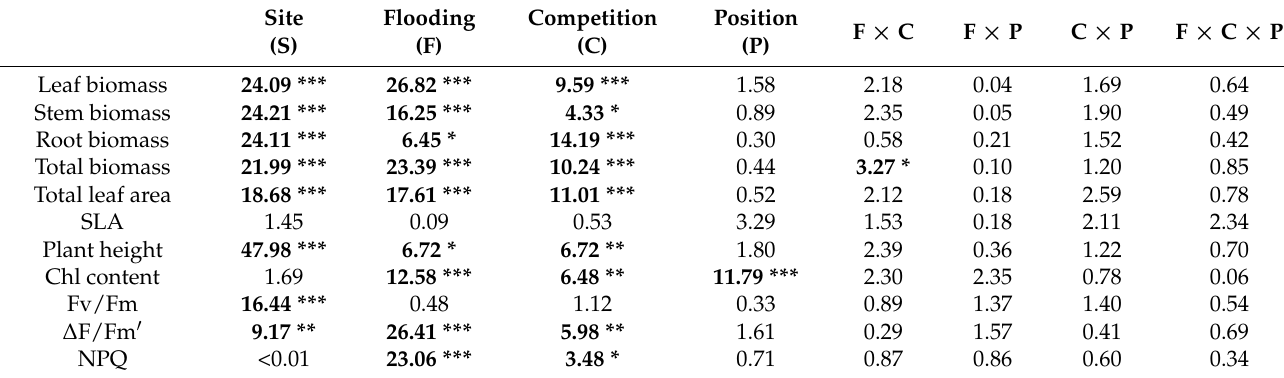
Table 1. Effects of site, flooding, competition, and position on growth and photosynthetic variables of P. hydropiper .